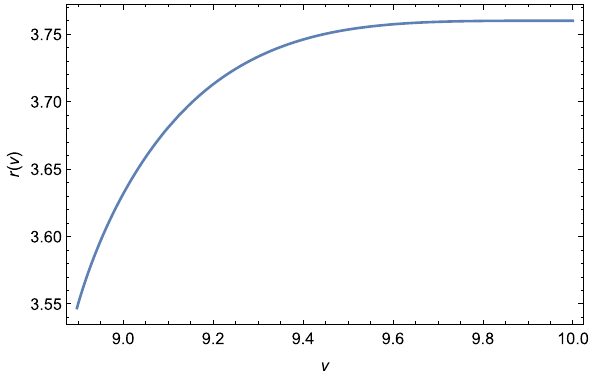
Fig. 2 The evolution of the ISCO in the Vaidya-AdS4 spacetime